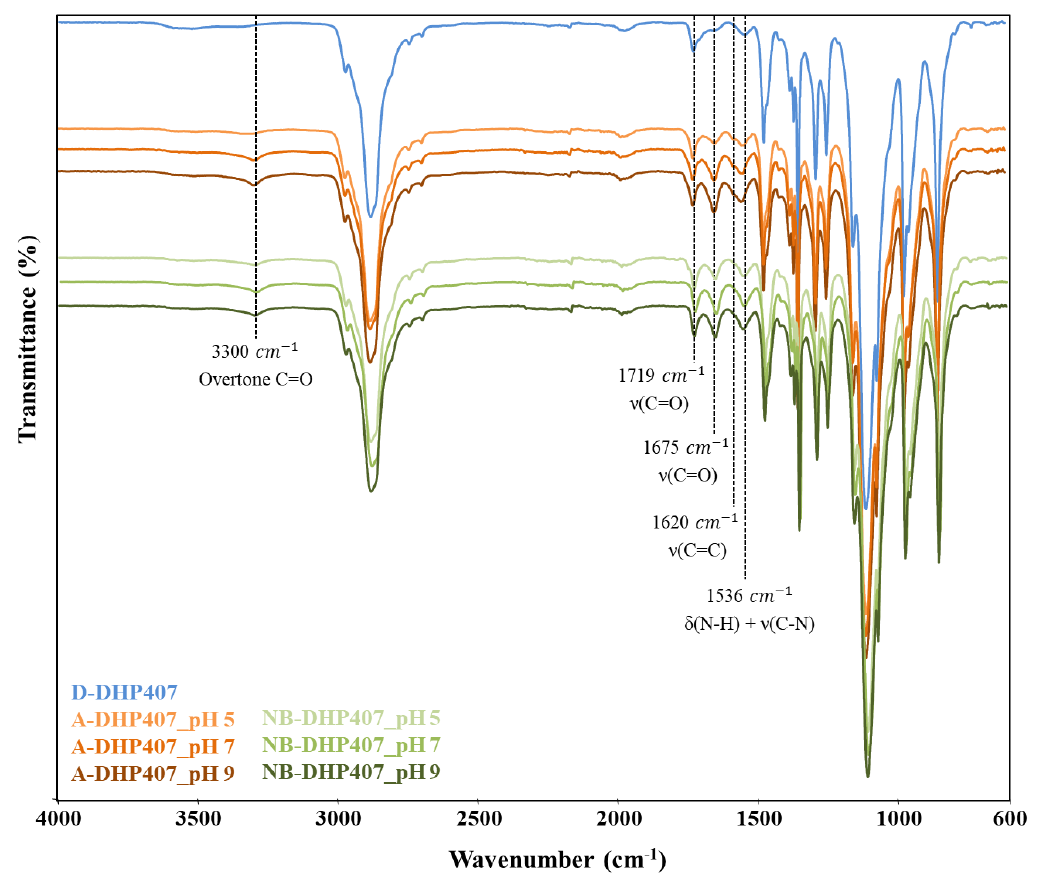
Figure 3. ATR-FTIR spectra of D-DHP407 (blue, control condition), A-DHP407_pHX (orange) and NB-DHP407_pHX (green). The increasing color intensity of the spectrum stands for the increasing reaction pH from 5 to 9. Dashed lines highlight the peaks attributed to the newly formed amide bonds and to C=C stretching vibration.